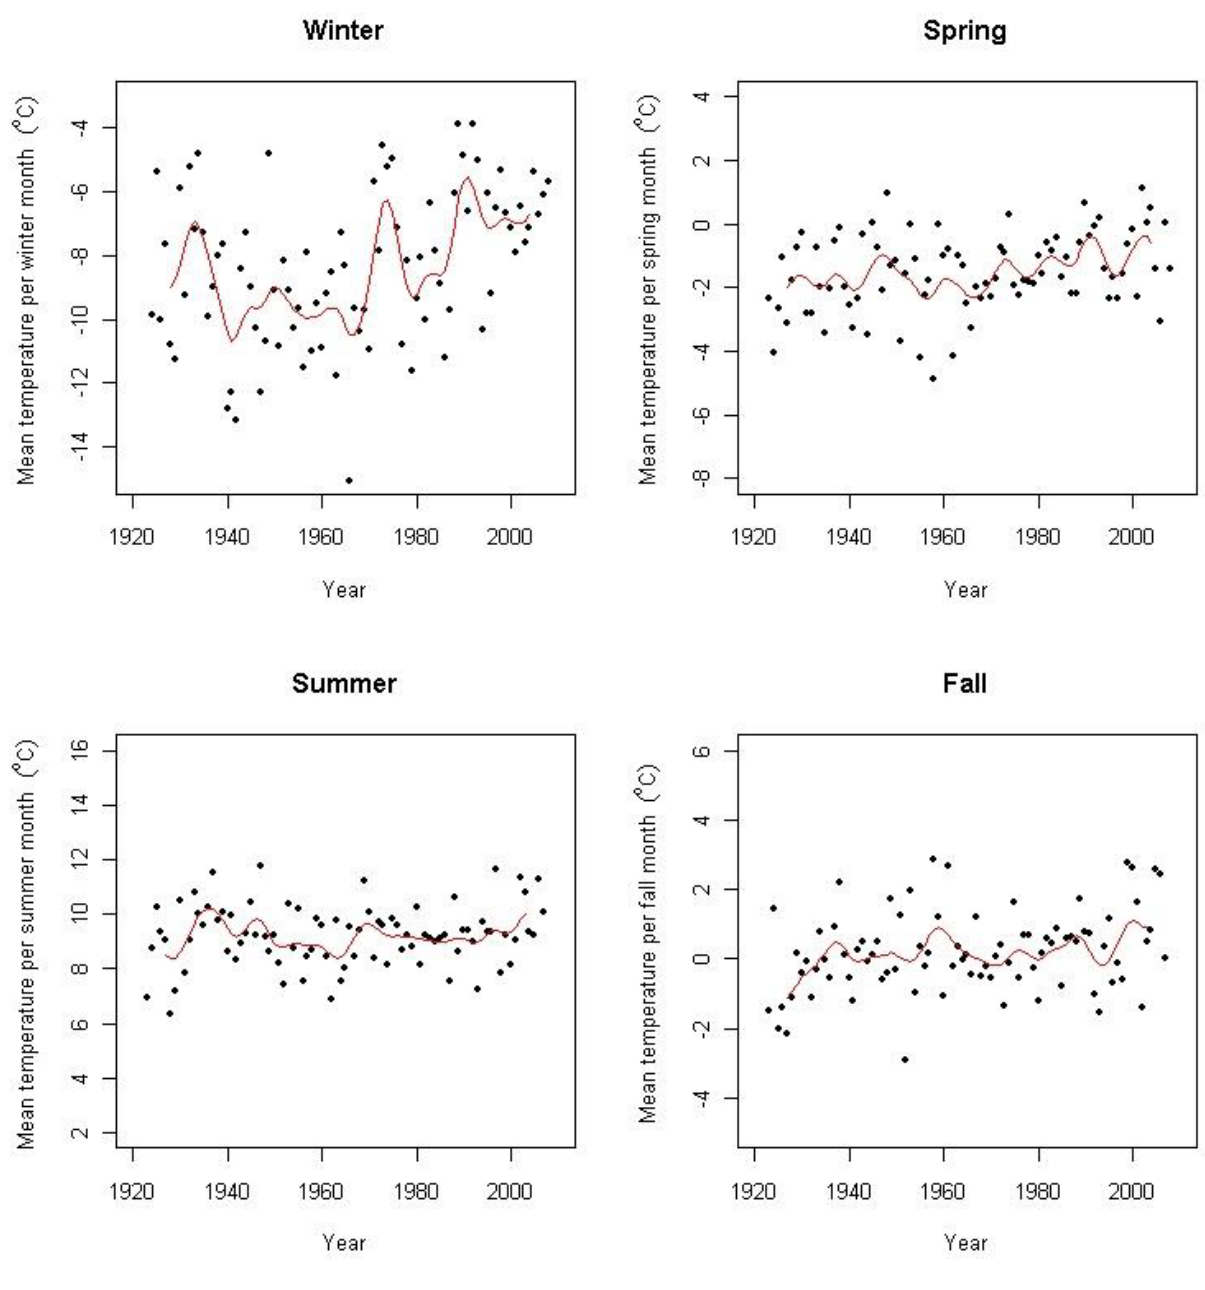
Figure 2. Seasonal mean temperature (dots) for each year in the period from 1923 to 2008 at Fokstugu (972 m a.s.l.). Winter is defined as December to February, spring as March to May, summer as June to August, and fall as September to November. The lines show smoothed data after a Gaussian filter with a standard deviation of 2 years is